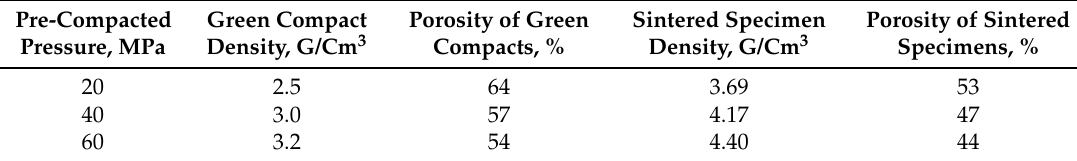
Table 1. The pre-compacted pressure, density, and porosity of green compacts and sintered specimens. Pre-Compacted